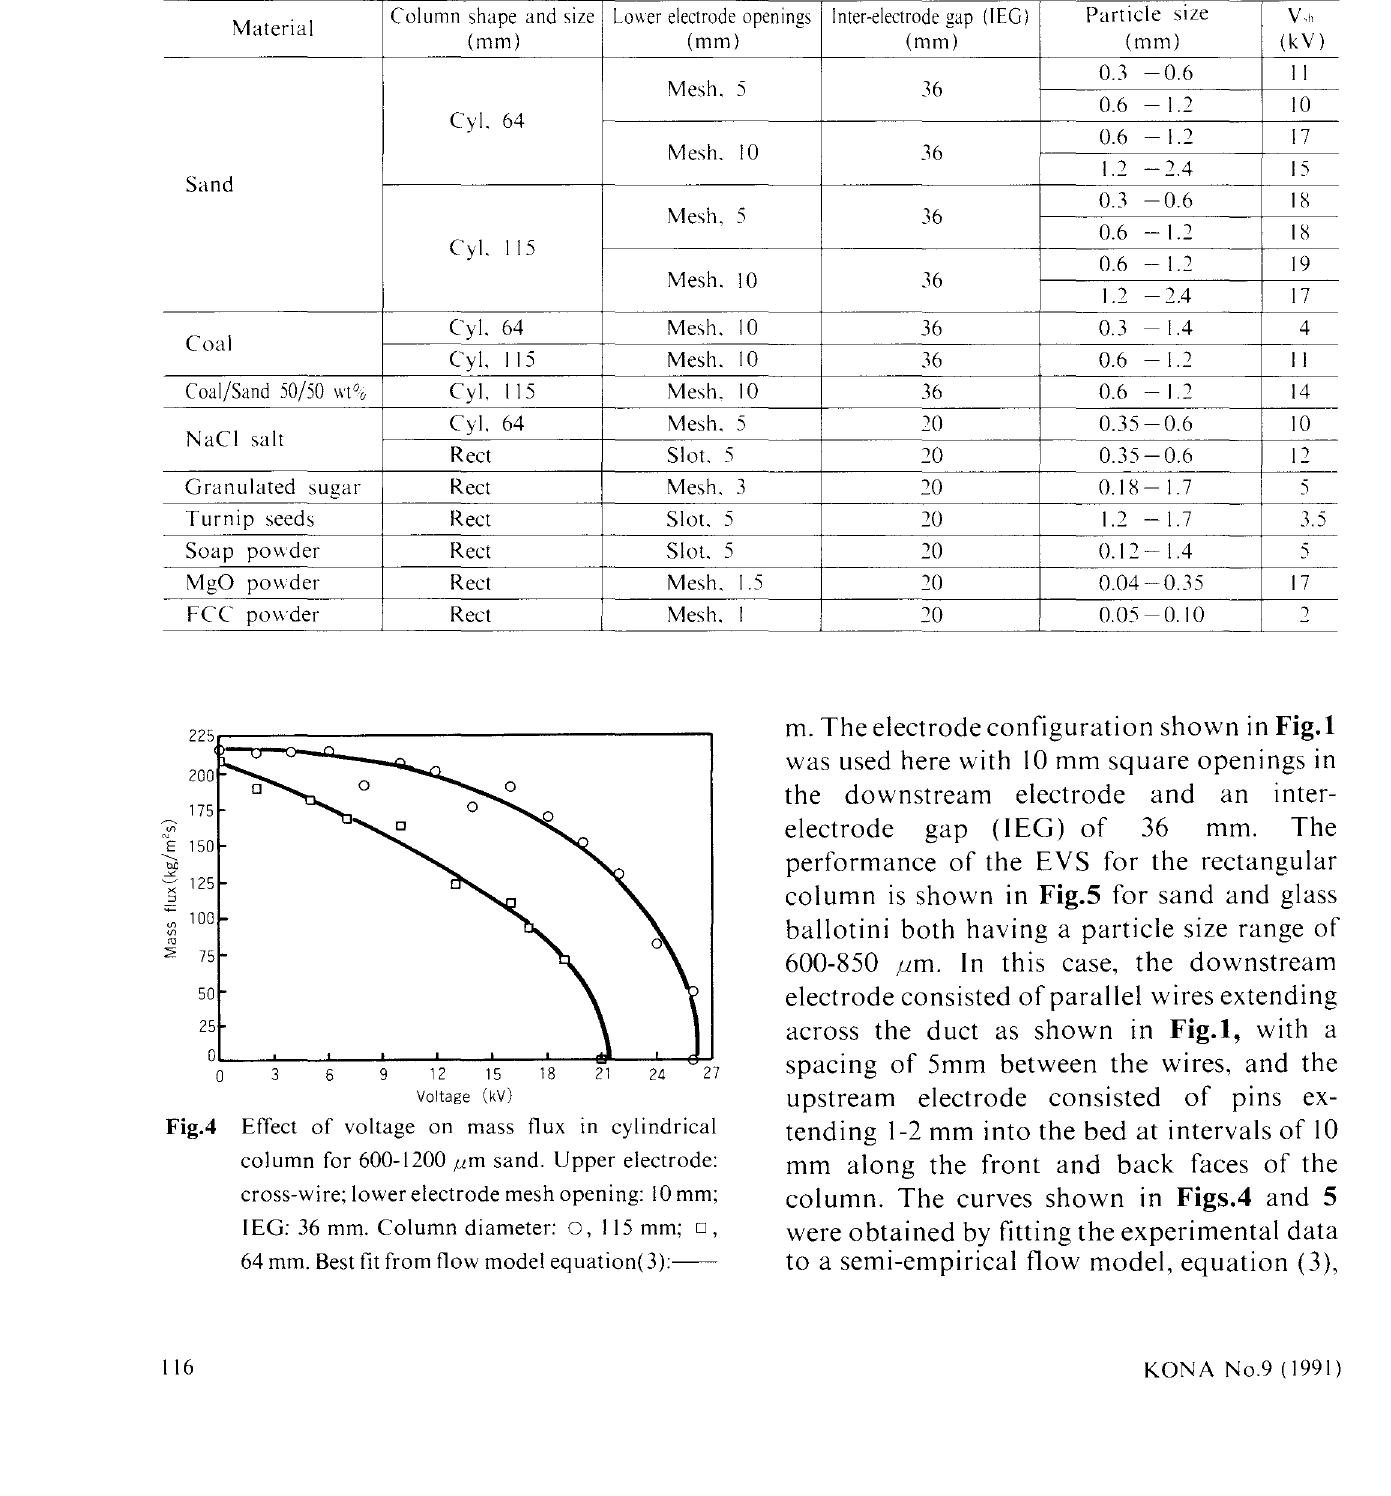
Table l Upper limits of V.h for materials in varying electrode configuration,. Material